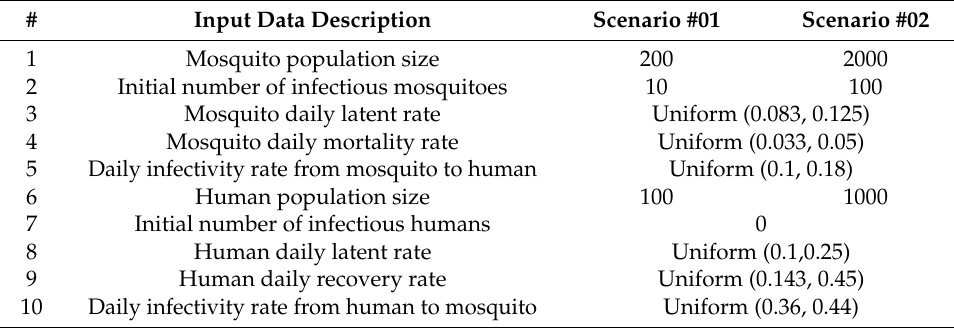
Table 4. Input parameter values of the baseline